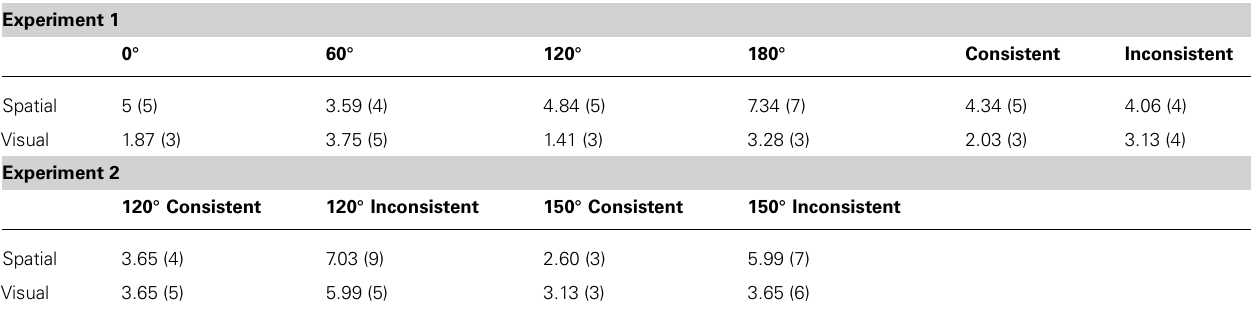
Table 1 | Percentage error rates (standard deviations) from Experiments 1 and